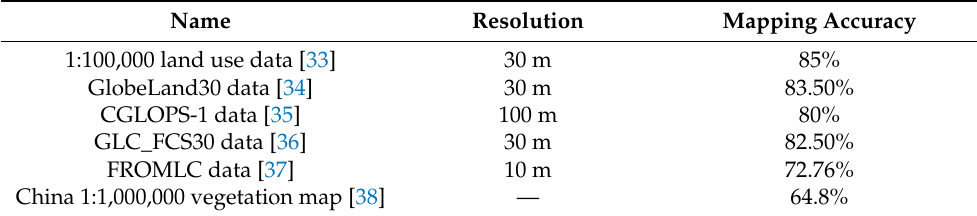
Table 2. Details of the six non-homogenous remote sensing monitoring datasets used in this